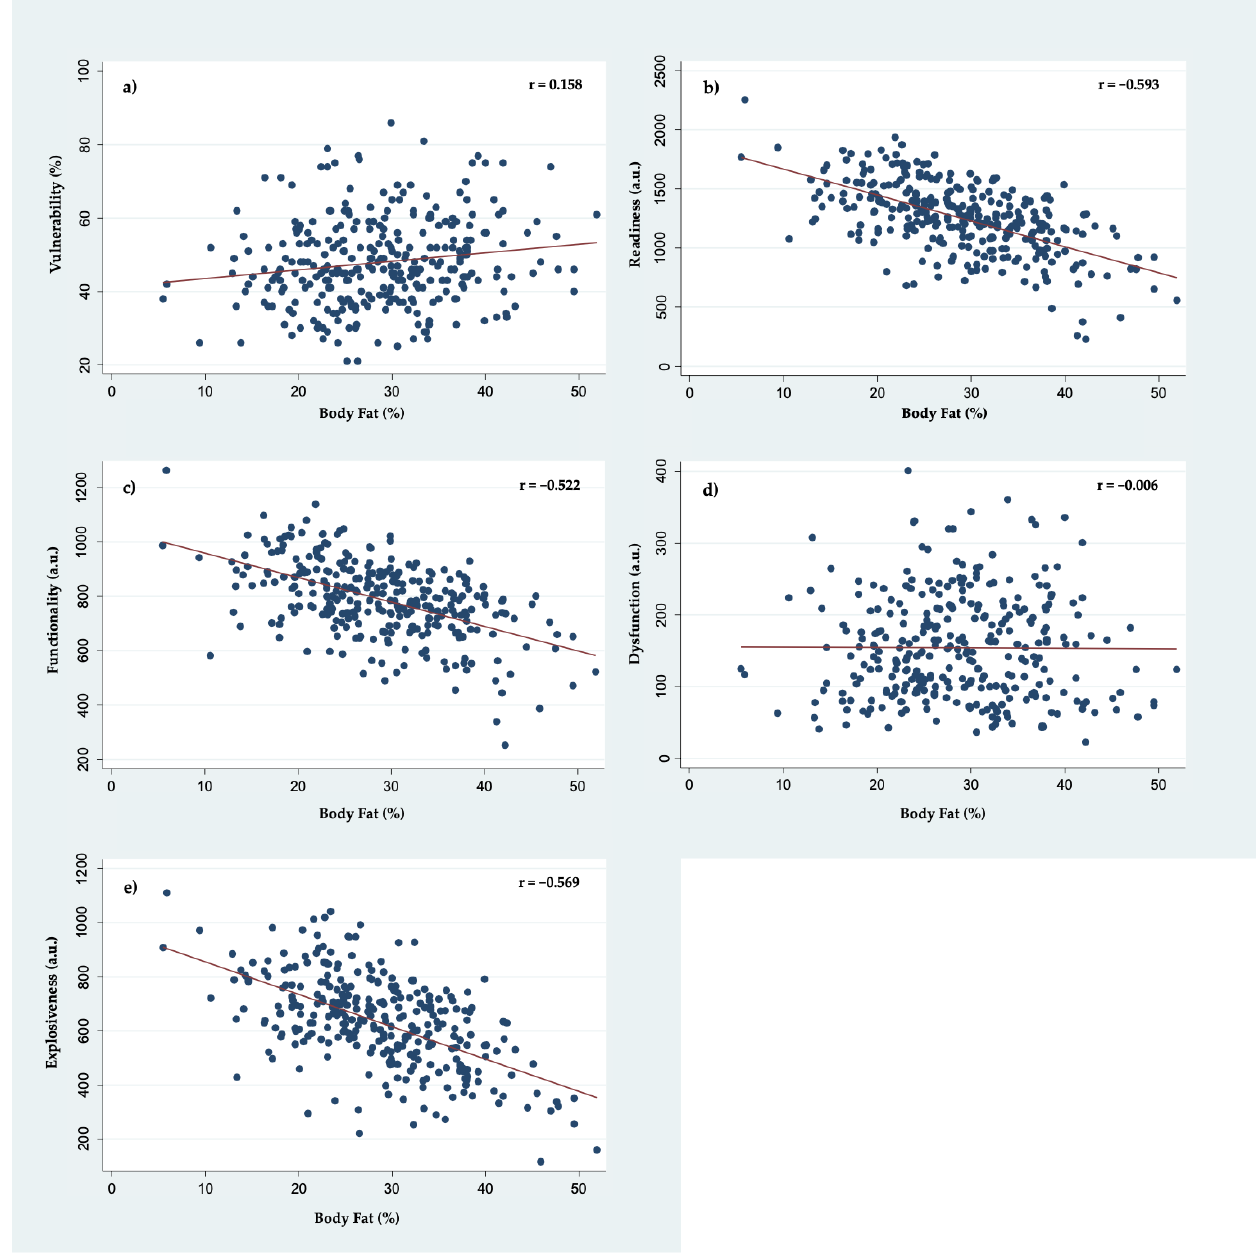
Figure 1. Correlation plots of BF% with ( a ) vulnerability, ( b ) readiness, ( c ) functionality, ( d ) dysfunction, and ( e ) explosiveness scores derived from a 3D-MCS during functional movement screening protocol.